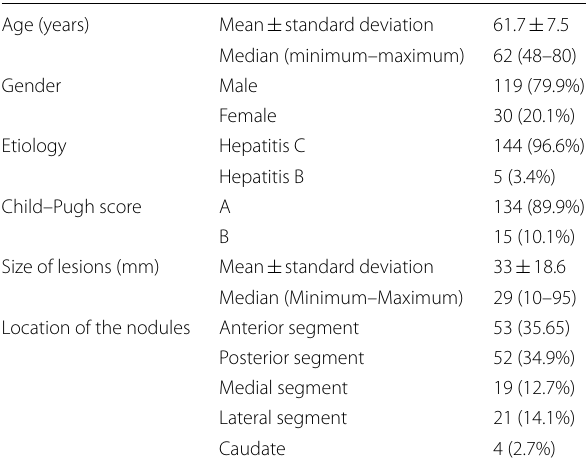
Table 2 Baseline characteristics